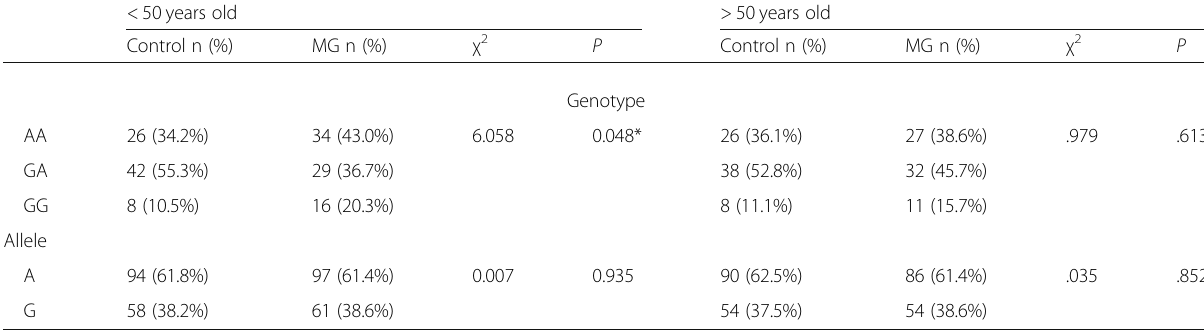
Table 3 Genotype and allele frequencies of BAFF rs2893321 in patients younger and older younger than 50